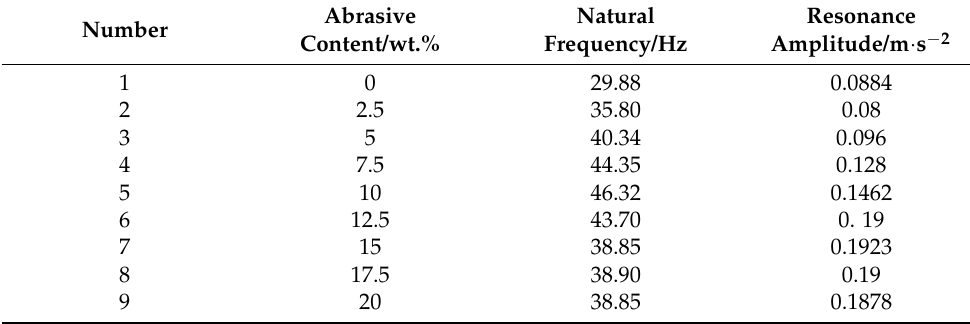
Table 2. Experiment table at 50% ultrasonic amplitude.